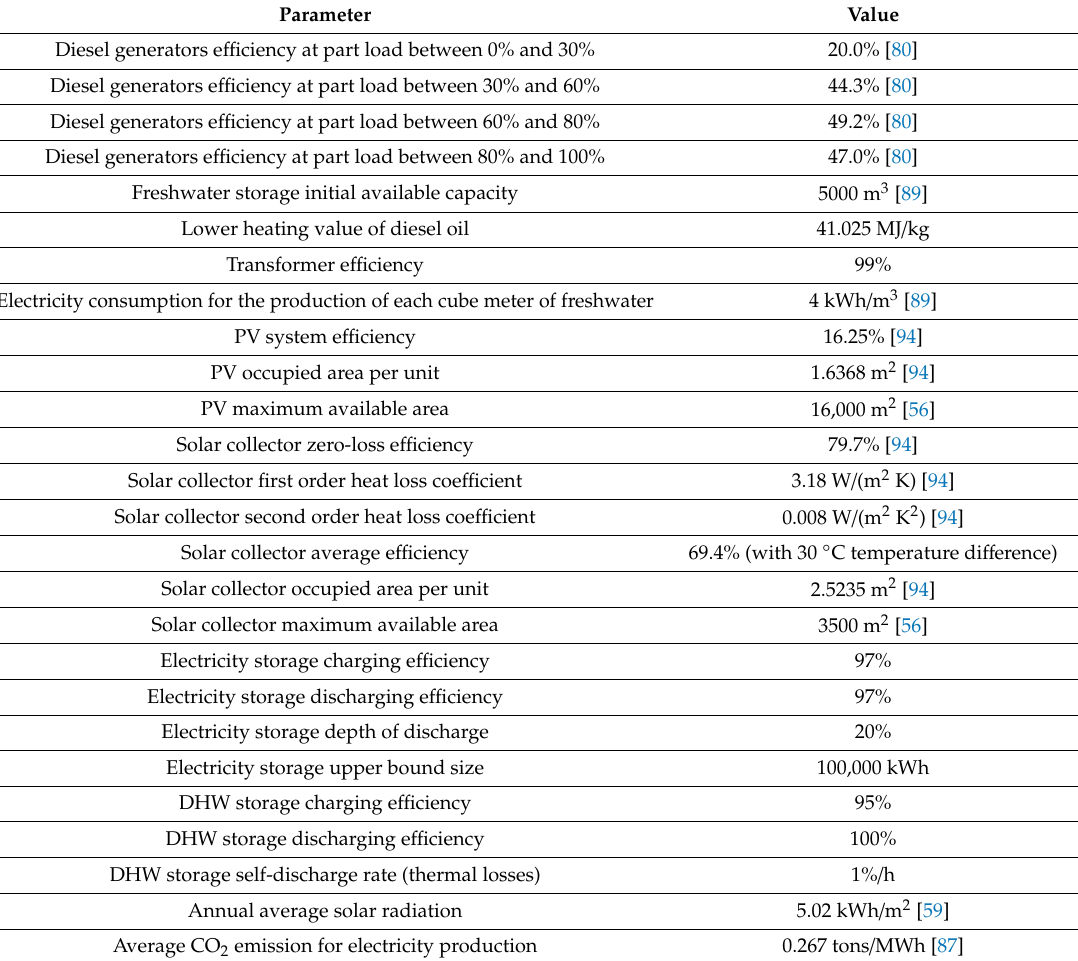
Table A5. Technical and environmental